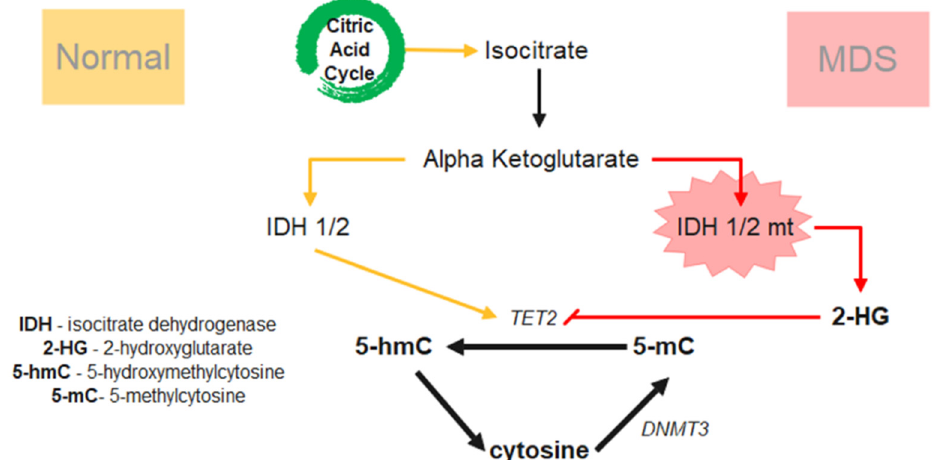
Figure 3. Mechanisms of DNA methylation under epigenetic dysregulation in MDS. Under normal circumstances, IDH1/2 promotes the TET2 genes to perform the conversion of 5-mC to 5-hMC, trig- gering DNA methylation. However, IDH1/2 mutations are often seen in MDS causing the inhibition of TET2 , resulting in global hypomethylation but loci-specific hypermethylation.